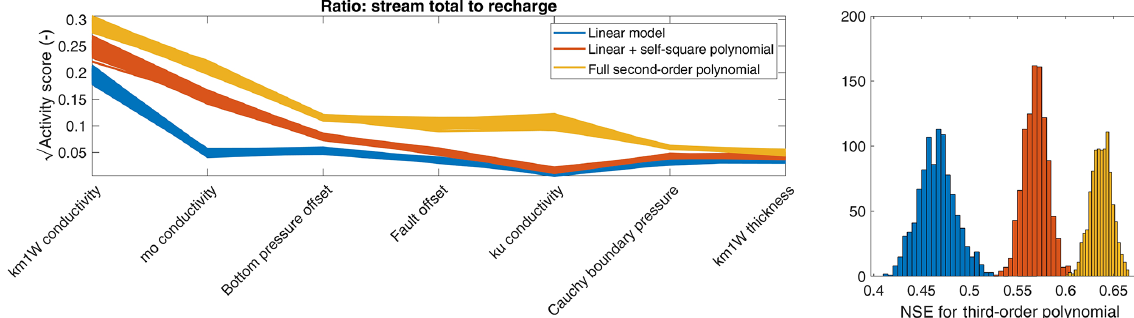
Figure A4. Square root of activity score and corresponding NSE for the ratio of stream discharge to incoming recharge using different approximations to compute the